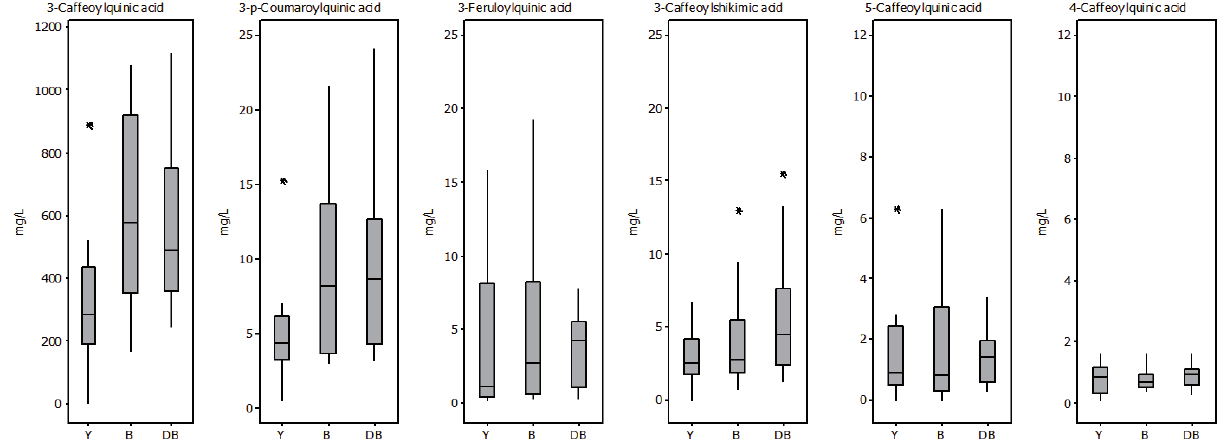
Fig. 5: Box plots of concentrations (mg/L) of individual hydroxycinnamic acids in juices of plum varieties with yellow (Y), blue (B) and dark blue (DB) skin.